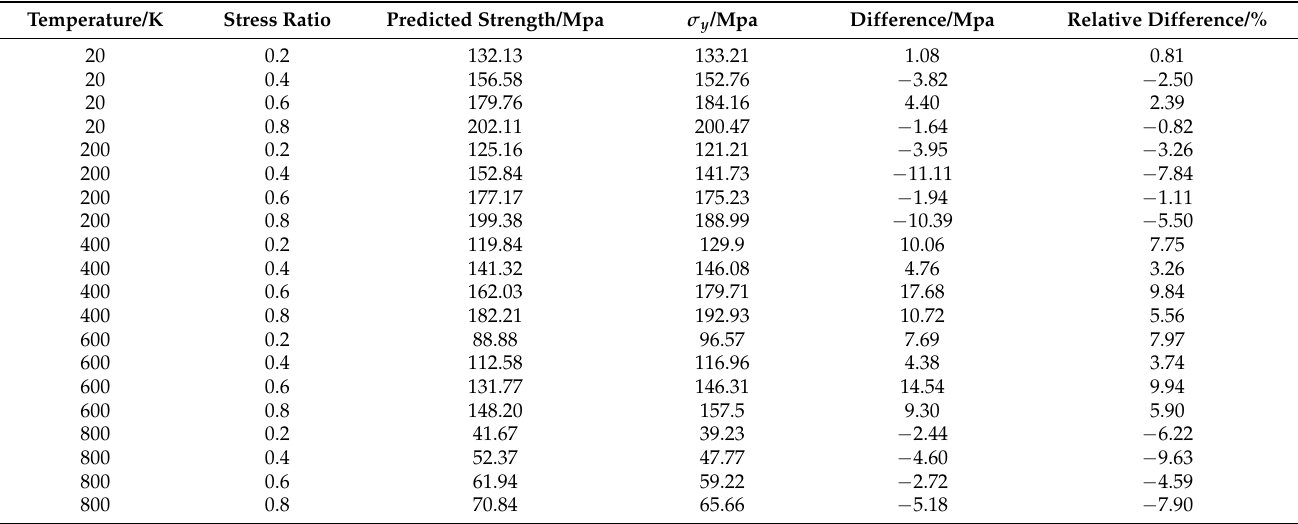
Table 9. Comparison between calculation results of the strength formula and test